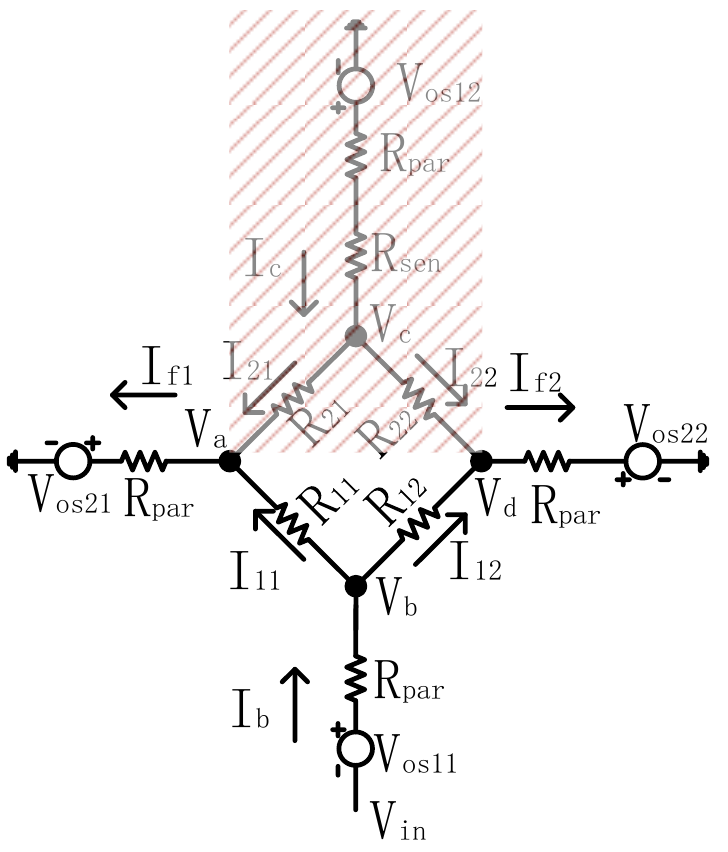
Figure 5. A 2 × 2 array circuit model including parasitic effects and crosstalk current effect for DZCM.